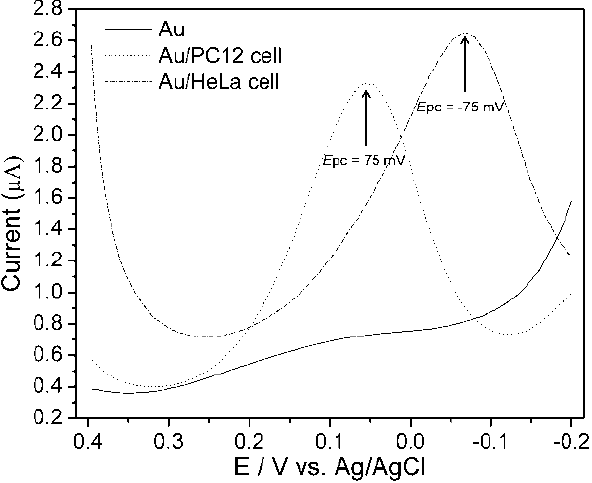
Figure 6. Differential pulse voltammogram (DPV) of PC12 and HeLa cell on collagen modified Au surface. DPV was measured using PBS (0.01 M, pH 7.4) as an electrolyte at